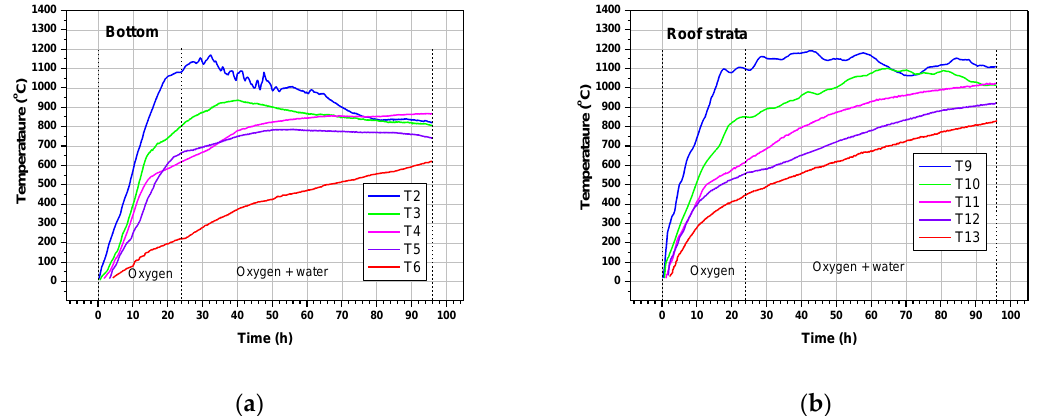
Figure 10. Distributions of temperatures during “Six Feet” semi-anthracite gasification at 20 bar: ( a ) seam bottom, ( b ) roof strata.